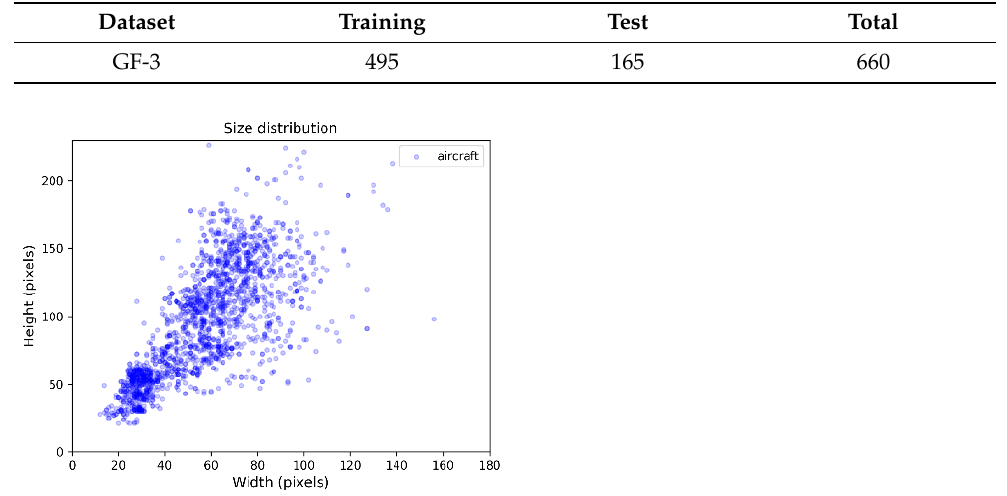
Figure 7. Size distribution of aircraft in the GF3